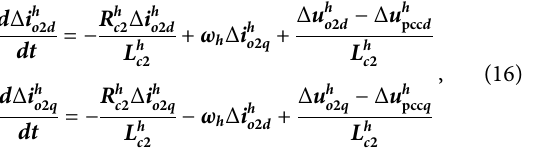
line resistances (inductances), respectively; Δ i h o 1 d and Δ i h o 1 q are the